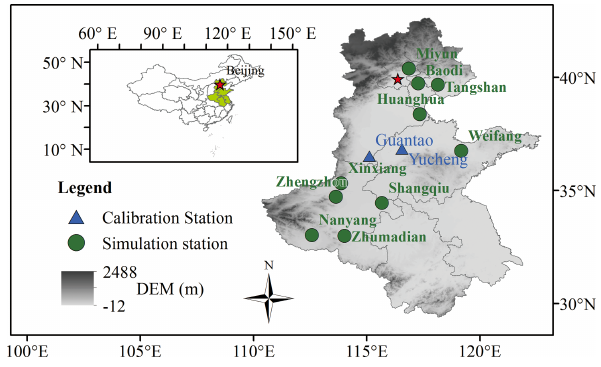
Figure 1. Distribution map of the study area and observation sites.